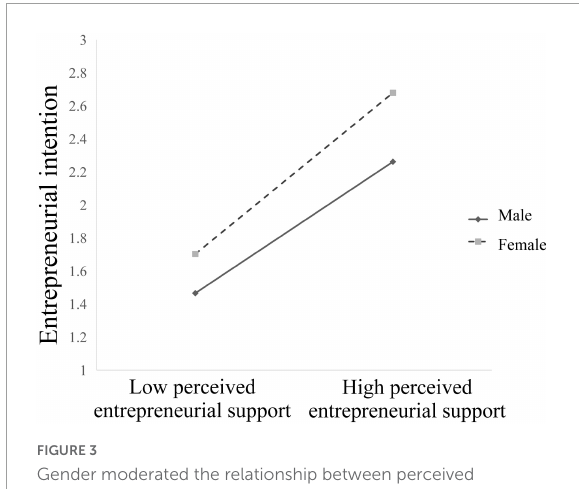
FIGURE3 Gender moderated the relationship between perceived entreprenieurial support and entreprenieurial